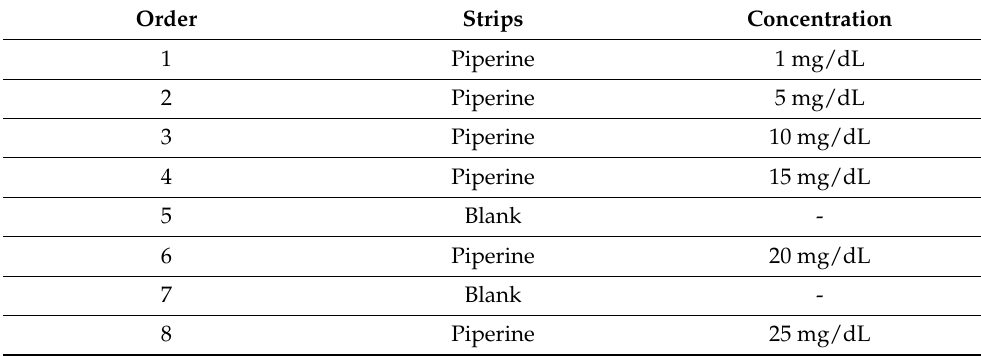
Table 1. The order in which the piperine impregnated taste strips and blanks were